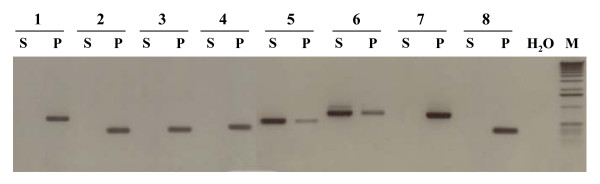
Examples of PCR amplification of ESTs originatingeither from sunflower (S) or from Plasmopara halstedii (P). Each primer pair was tested using DNA from either sunflower (S), or Plasmopara halstedii sporangia (P). The ESTs tested here are: 1, HSP 70 [GenBank:CB174638]; 2, Pyruvate kinase [GenBank:CB174571]; 3, Superoxyde dismutase [GenBank:CB174636]; 4, Proteasome 26 S beta subunit [GenBank:CB174617]; protein; 6, Asparagine synthase; 7, Elicitor [GenBank:CB174646]; 8, Cyclophilin B [GenBank:CB174647]. M: molecular marker. H20: negative control. The PCR products were separated on 1.5% agarose gel.